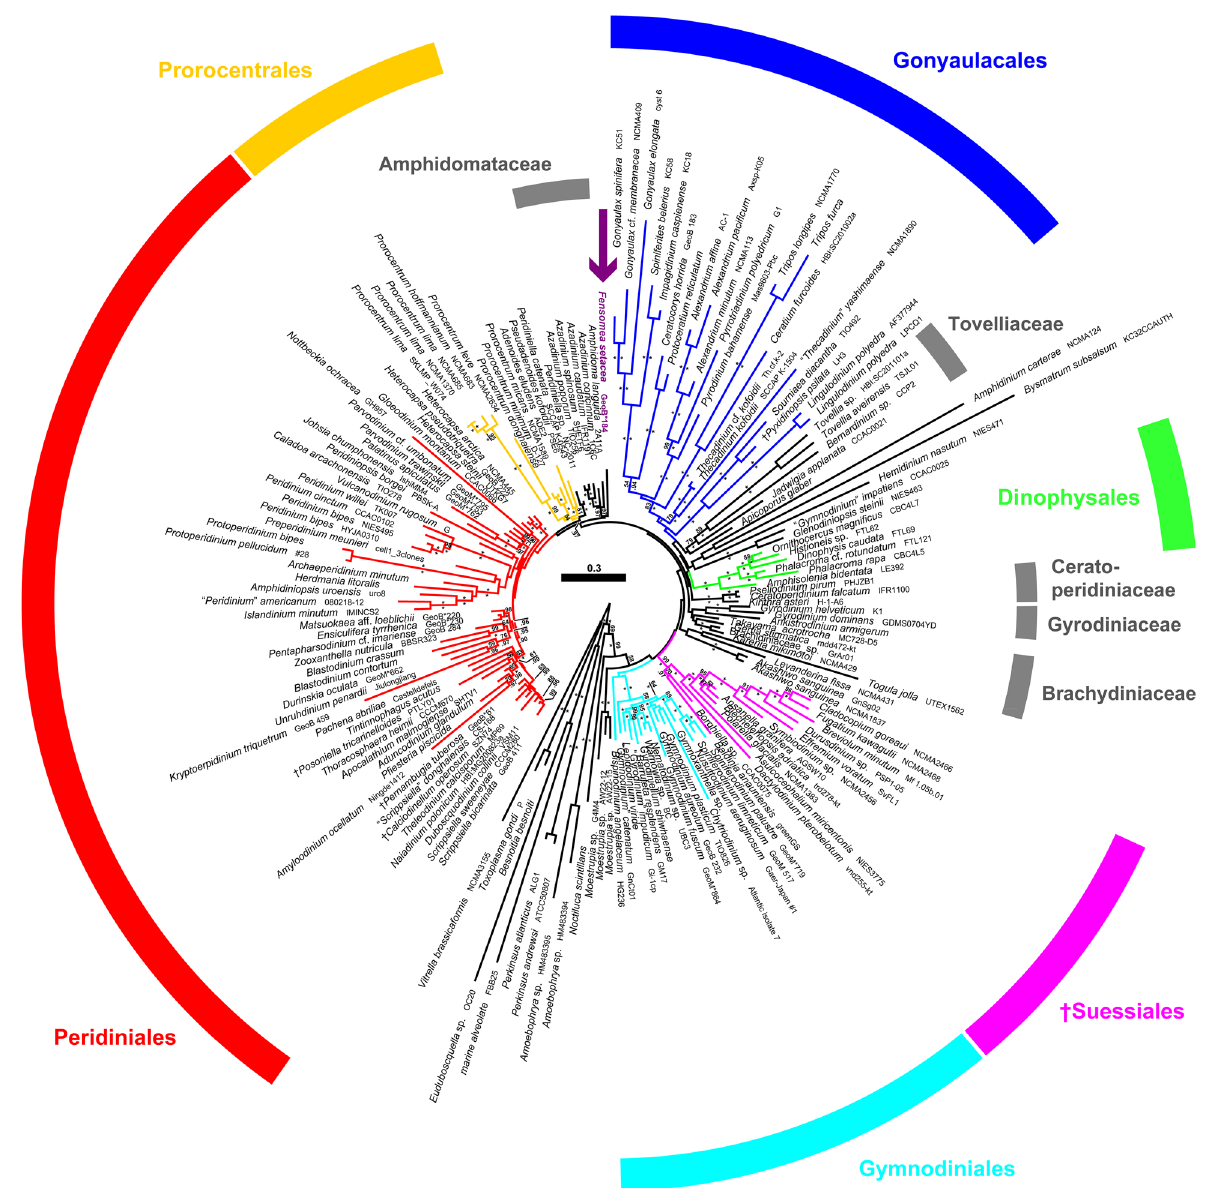
Figure 8. A molecular reference tree recognizing major groups of dinophytes. Maximum Likelihood (ML) tree of 161 systematically representative dinophyte sequences (with strain number information) inferred from a rRNA nucleotide alignment (3632 parsimony-informative positions). The numbers on the branches are ML bootstrap (above the branch line) and Bayesian probabilities (below the branch line) for the clusters (asterisks indicate maximal support values; values under 50 for the ML bootstrap and 0.90 for Bayesian probability are not shown). Note the phylogenetic position of Fensomea setacea , gen. & sp. nov . , which indicates it cannot be clearly assigned to Gonyaulacales or